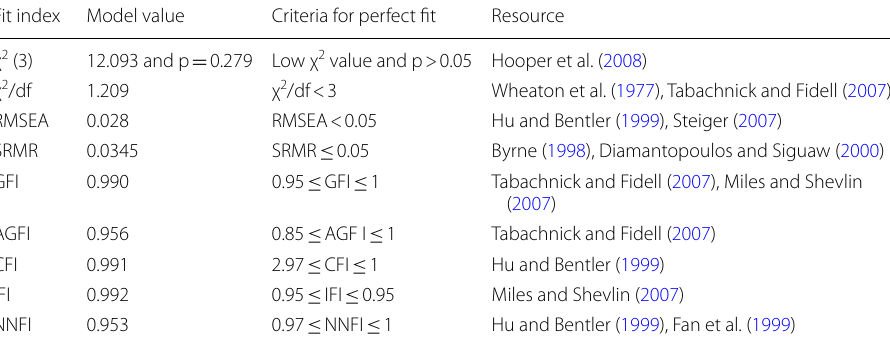
Table 4 Evaluation of model fit